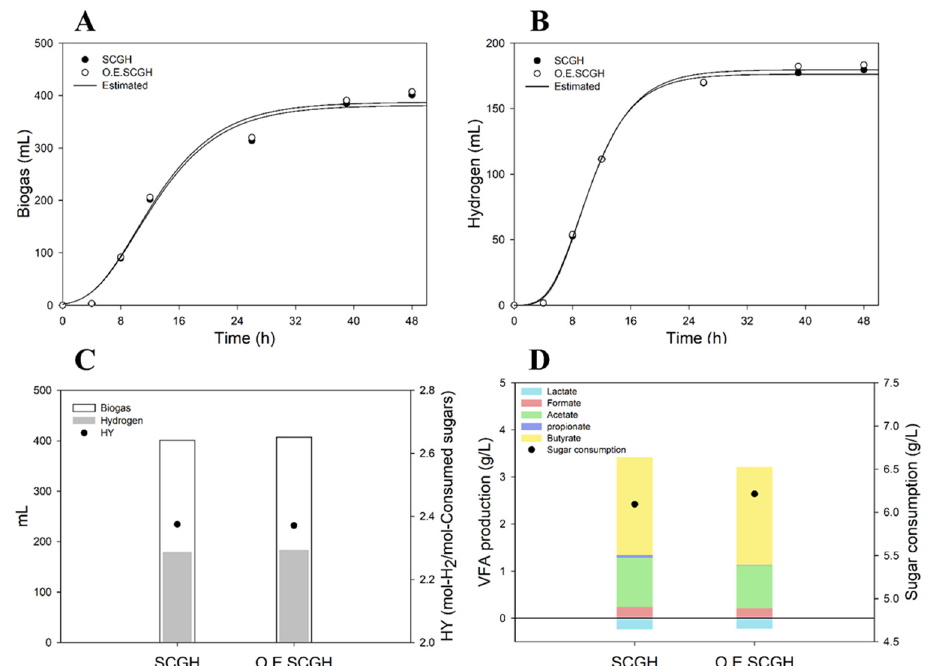
Figure 3. Comparison of dark fermentation productivities based on SCGH, OESCGH media (same volumes of hydrolysates in media [30% ( v / v )]). ( A ) biogas profile; ( B ) hydrogen profile; ( C ) production amount of biogas and hydrogen, and hydrogen yield; and ( D ) VFA production and sugar consumption. Table 3. Comparisons of hydrogen productivities using various biomass.